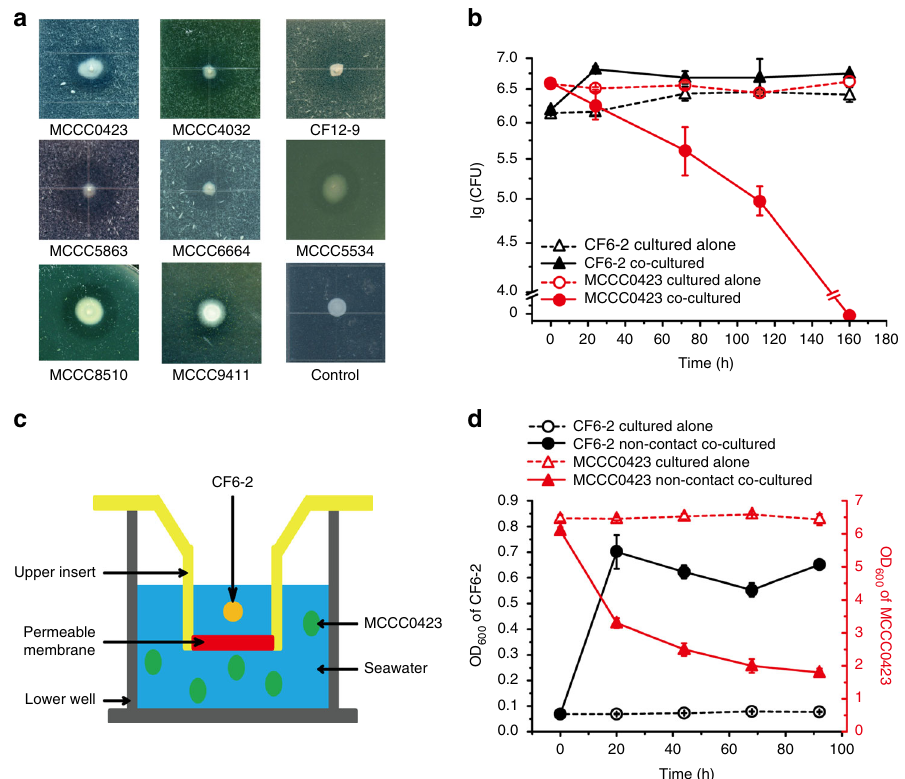
Fig. 1 Predation of Gram-positive bacteria by strain CF6-2. a The killing effect of strain CF6-2 on eight Gram-positive marine bacteria on agar plates. Strain CF6-2 was spotted and grew on each plate containing the cells of the indicated strain at 20 °C for 3 days until a clear zone around CF6-2 colony formed. MCCC0423, Staphylococcus warneri MCCC1A00423 (peptide stem, Ae(q)Ka; peptide bridge, GGGGG) 12 ; MCCC4032, Micrococcus luteus MCCC1A04032 (peptide stem, Ae(q)Ka/Ae(G)Ka; peptide bridge, EG/Ae(G)Ka) 16 ; CF12-9, Bacillus sp. CF12-9 (peptide stem, Ae(q)Ka/AeKa/AeKa; peptide bridge, G/d(n)/Ad) 16 ; MCCC5863, Sporosarcina aquimarina MCCC1A05863 (peptide stem, AeKa; peptide bridge, Ge) 16, 51 ; MCCC6664, Streptomyces sp. MCCC1A06664 (peptide stem, Ae(q)pa; peptide bridge, G) 16, 52 . MCCC5534, Salinibacterium amurskyense MCCC1A05534 (PG- containing Lys, Orn, Ala, Gly, and Glu) 16, 53 ; MCCC8510, Exiguobacterium sp. MCCC1A08510 (peptide stem, Ae(q)Ka; peptide bridge, G);